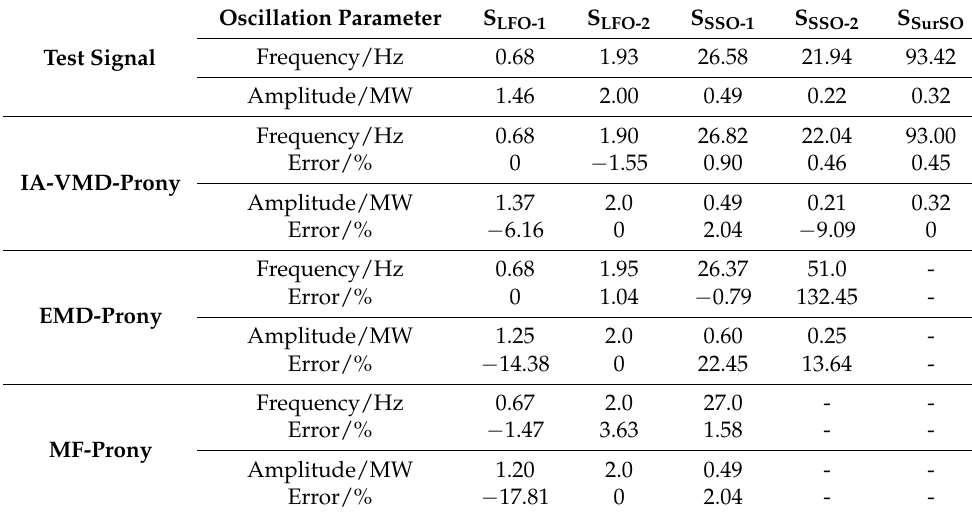
Table 1. Fitting errors of the different